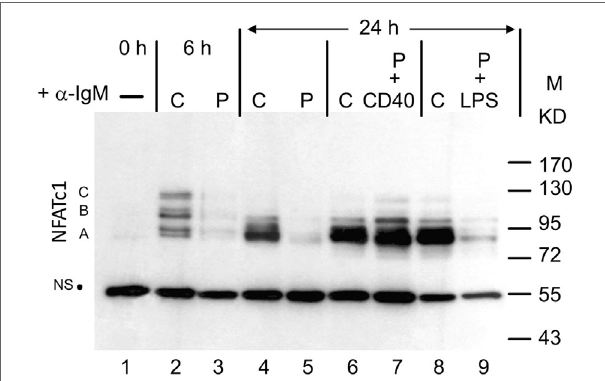
FigUre 1 | Induction of NFATc1 proteins in splenic B cells. Western blot using the 7A6 mAb directed against all NFATc1 proteins. B cells were left untreated ( − ), continuously treated (C) with α -IgM for 6 or 24 h, or “pulsed” (P) for 30 min at 4°C with α -IgM, washed and incubated for 4 h without or with α -CD40 or LPS. M, molecular weight marker; NS, non-specific band that indicates—as the ponceau red stain of the filter (not shown)—equal loading of the gel. One typical blot of more than three assays is shown. A, B, and C, NFATc1 isoforms.